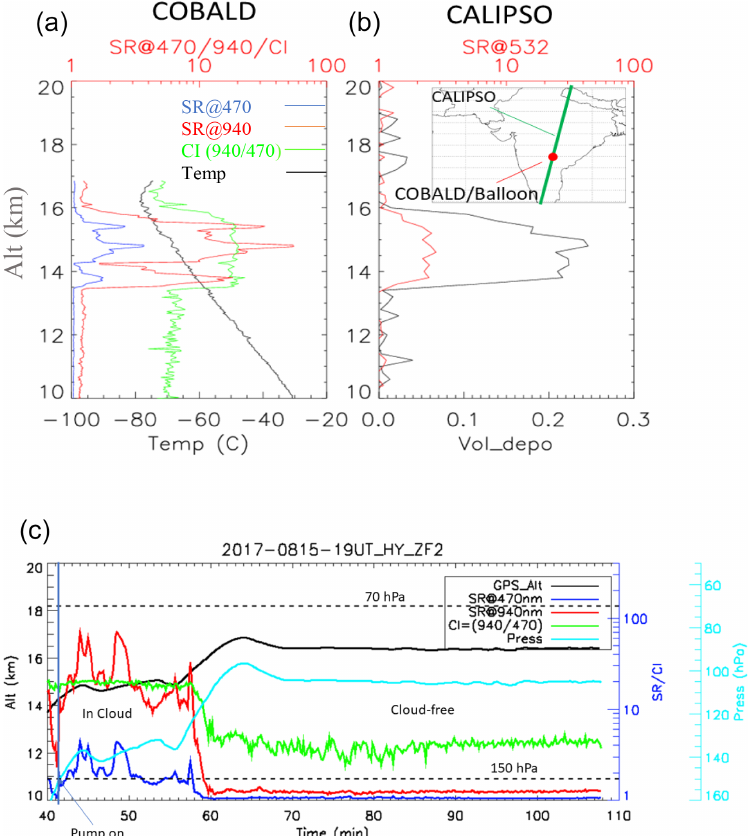
Figure 4. (a) COBALD balloon in situ scattering ratio (SR) and color index (CI) profiles and (b) CALIOP satellite SR and volume depo- larization profiles co-located in time and space (within 20km and 1h, respectively) on 15 August at 19:00UT. (c) Time series along ZF2 of SRs at 940 and 470nm from COBALD as well as the GPS altitude and measured pressure from the iMet